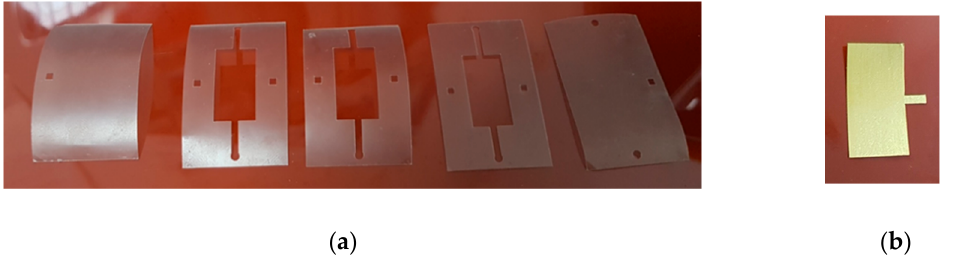
Figure 7. ( a ) Separate PVC layers of microfluidic capacitor, ( b ) gold electrodes for parallel plate capacitor.